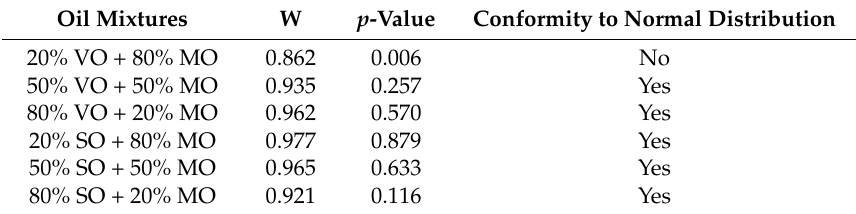
Table 9. Hypothesis test of conformity to normal distribution of oil mixtures in DC.